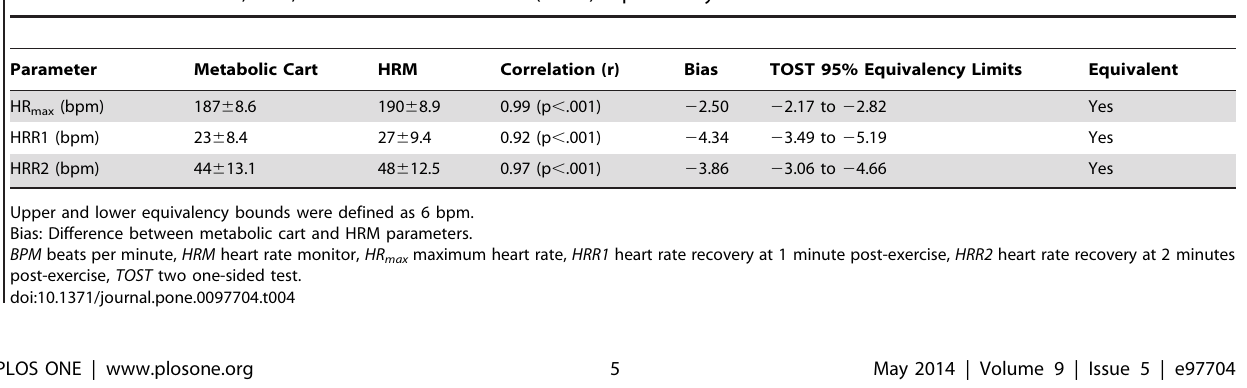
Table 4. Heart rate parameters obtained by the metabolic cart and HRM during the ETT (means 6 SD), correlation between metabolic cart and HRM, bias, and two one-sided test (TOST) equivalency limits.